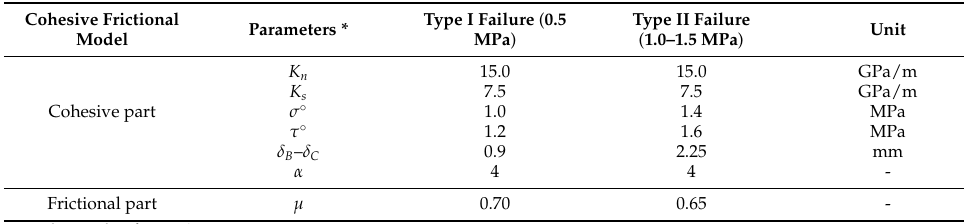
Table 6. Parameters of the